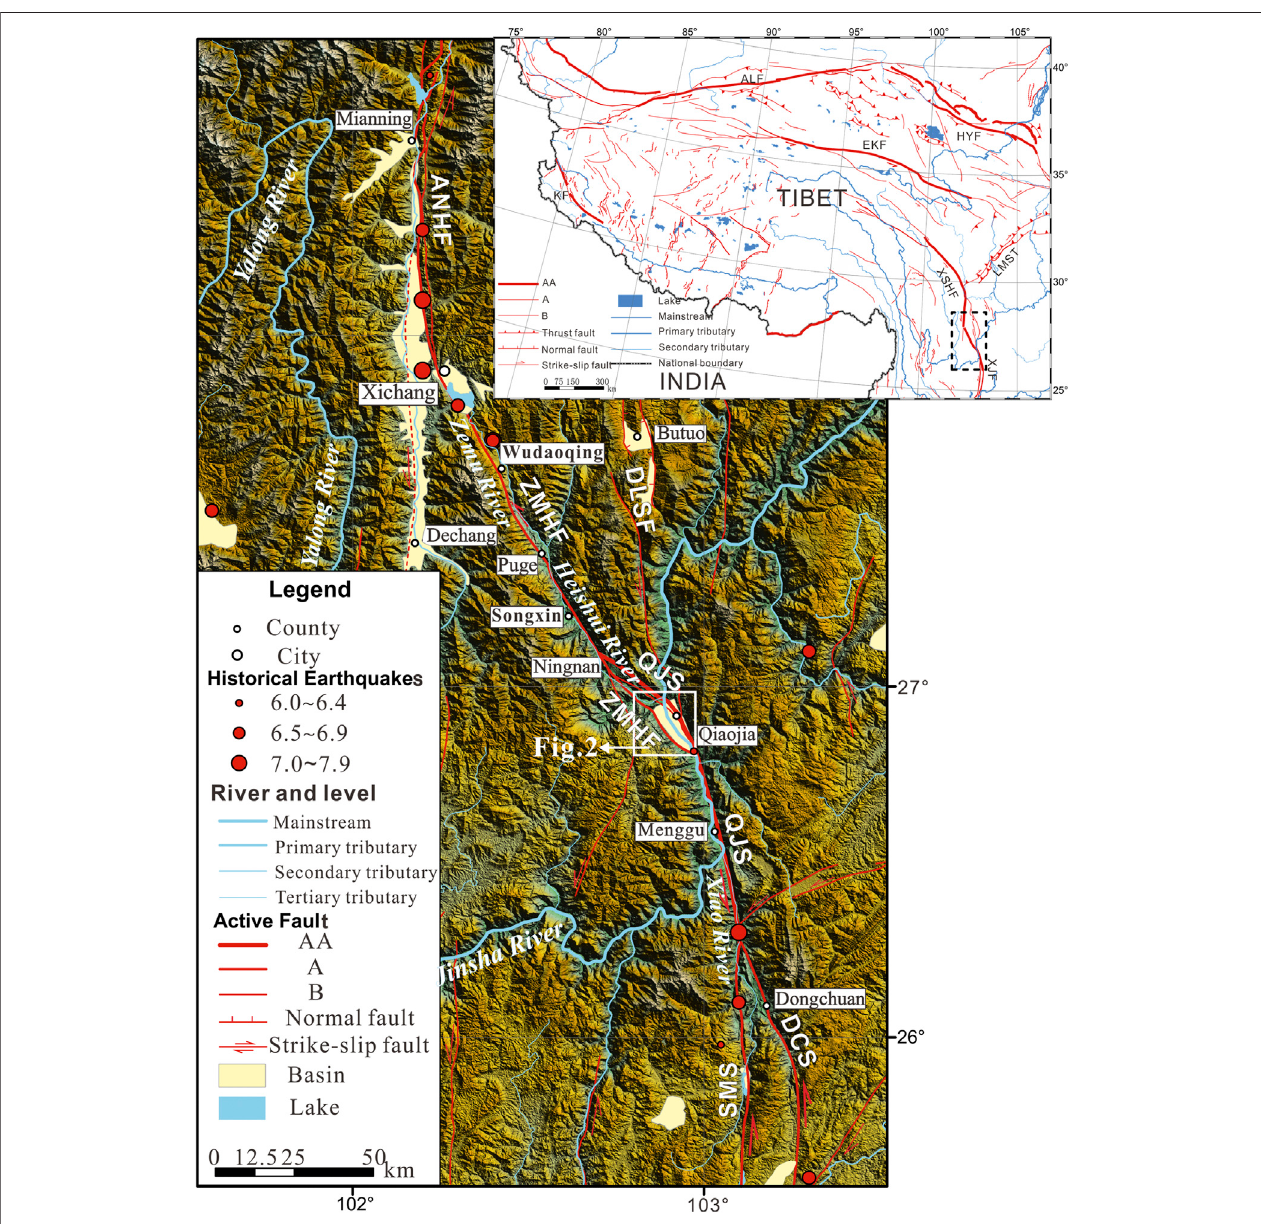
FIGURE 1 | Principal active faults, historical earthquakes with magnitude ≥ 6.0, basins, rivers, and main towns in the study area mapped on a Digital Elevation Model (ASTER GDEM res-30 m). KF (cid:1) Karakoram Fault; ALF (cid:1) Altyn Tagh Fault; EKF (cid:1) East Kunlun Fault; XSHF (cid:1) Xianshuihe Fault; ANHF (cid:1) Anninghe Fault; ZMHF (cid:1) ZemuheFault;DLSF (cid:1) DaliangshanFault;XJF (cid:1) XiaojiangFault;LMST (cid:1) LongmenshanThrust;QJS (cid:1) QiaojiaSegmeny;DCS (cid:1) DongchuanSegment;SMS (cid:1) Songming Segment. For the active faults, AA, A, and B indicate their activity of extremely strong, strong, and medium. Dashed rectangle in the inset marks the location of the study area. All vector data from Wu and Zhou (2018).